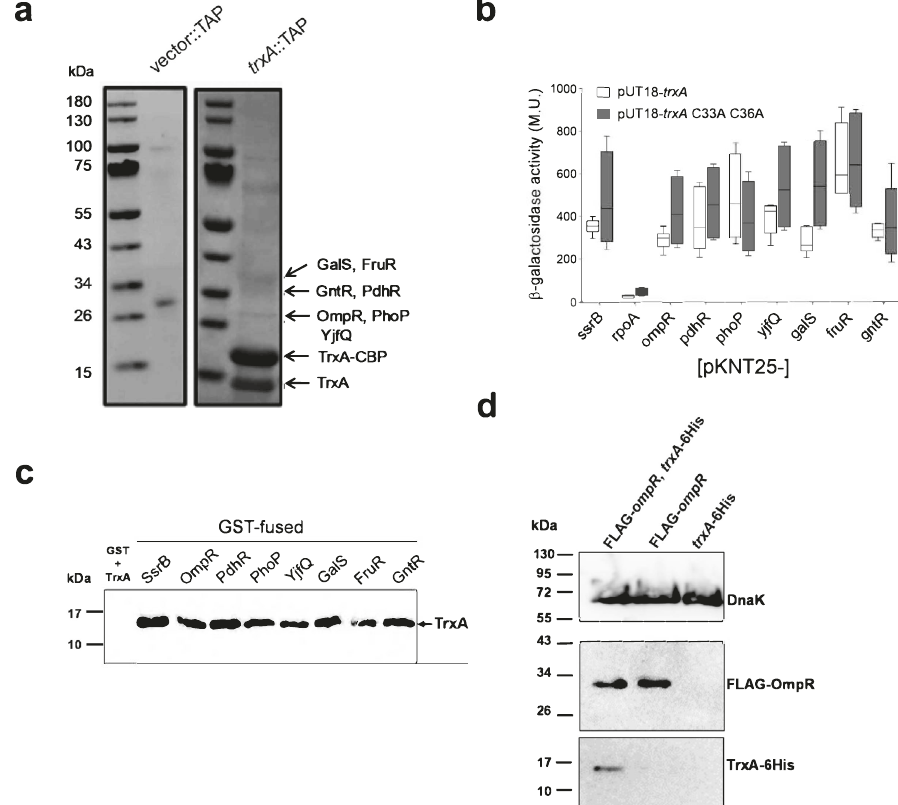
Fig.1|Thioredoxinbindstomultipletranscriptionalregulators.a PutativeTrxA binding partners were identi fi ed by mass spectrometry of cytoplasmic